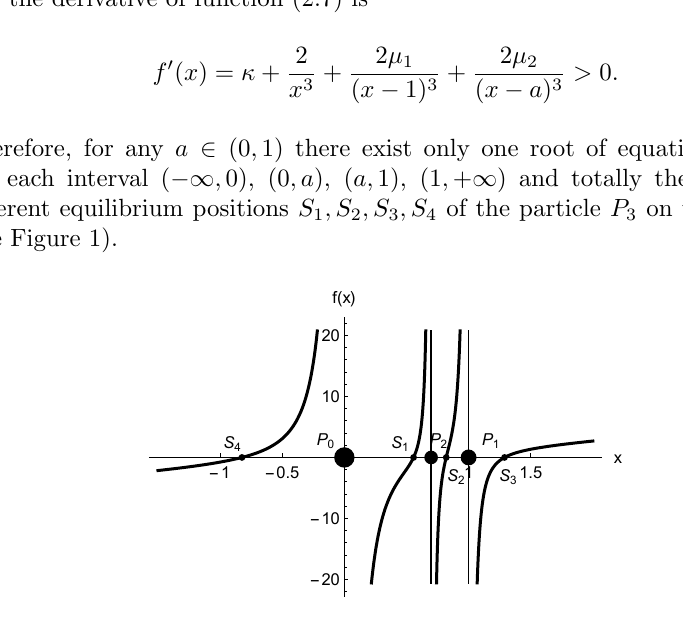
Figure 1. Collinear equilibrium positions S 1 , S 2 , S 3 , S 4 , µ 1 = 0 . 1, µ 2 = 0 . 04, 0 < a <